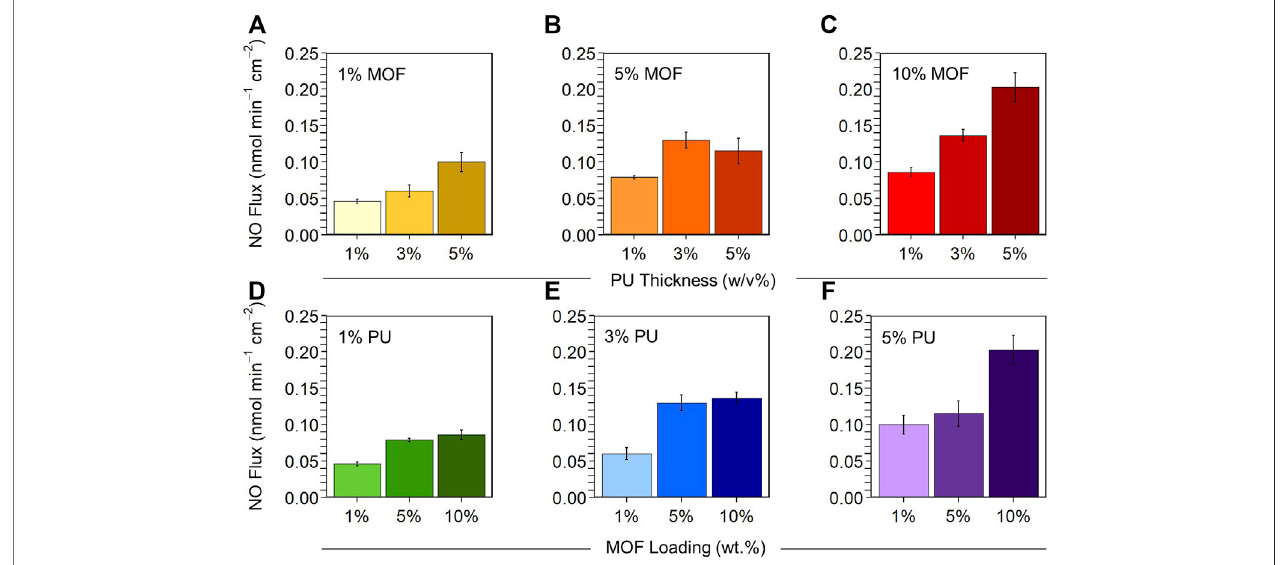
FIGURE 3 | Top: Varying PU concentration at different MOF loadings. (A) 1 wt.% MOF, (B) 5 wt.% MOF, (C) 10 wt.% MOF at 1, 3, and 5 w/v% PU. Bottom: VaryingMOFloadingatdifferentPUconcentrations. (D) 1w/v%PU, (E) 3w/v%PU, (F) 5w/v%PUat1,5,and10 wt.%MOF.ExperimentsconductedusingtheNOAin ultrapurewaterwithconstantN 2 bubblingat25 ° Cshieldedfromlightwith10×10 – 6 MGSNO.Composites(1.2 cmdiameter)fabricatedwithgroundMOF.Datareported as mean ± SD ( n = 3).